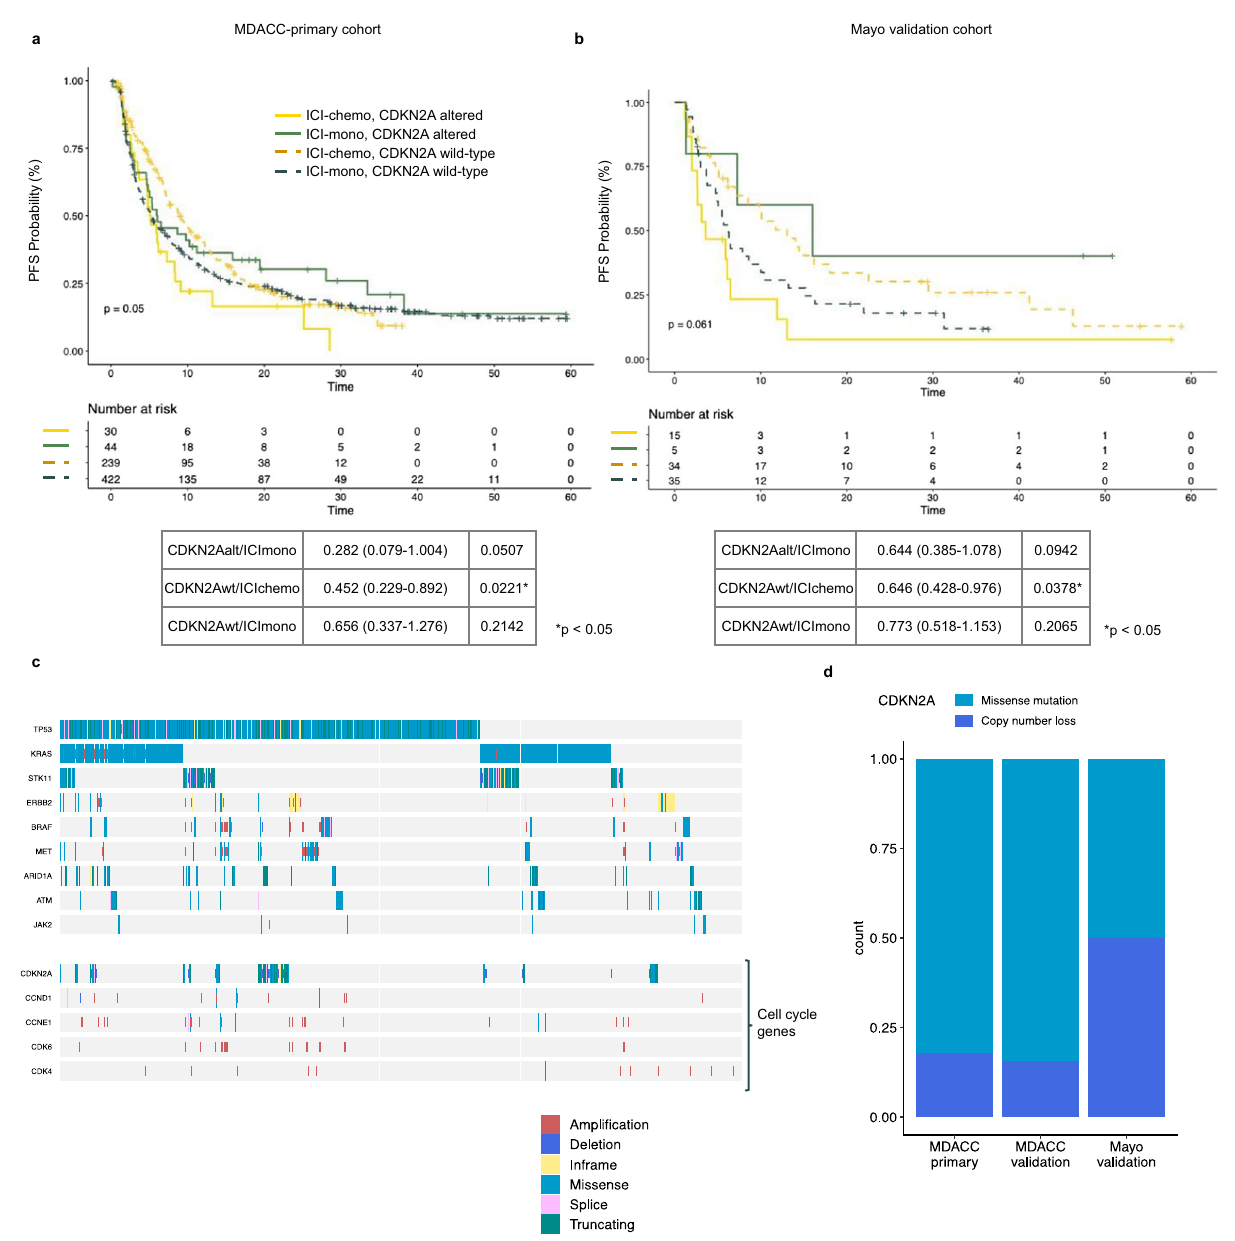
Fig. 5 | Association between CDKN2A and progression-free survival (PFS). a , b Kaplan – MeierplotofPFSinpatientstreatedwithimmunecheckpointinhibitor (ICI) monotherapy (ICI-mono) vs concurrent ICI-chemotherapy (ICI-chemo) strati- fi ed by CDKN2A in a , MDACC-primary ( n =735) and b , Mayo cohorts ( n =89); hazard ratio (HR) with 95% con fi dent interval and p values within the tables were calculated using unadjusted cox proportional hazards regression models; p values